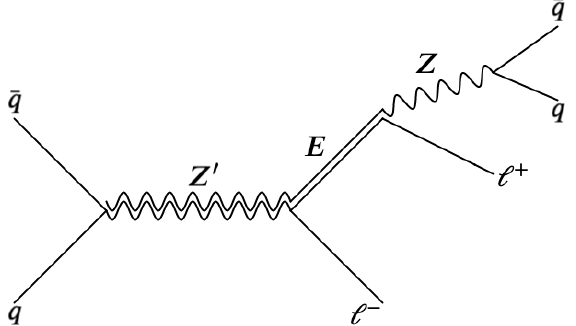
Figure 5. A representative Feynman diagram for the composite lepton model (see Section IV of [27]) where m jjl and m jjll can be used for searches of V = Z (cid:48) and a composite lepton-like particle E